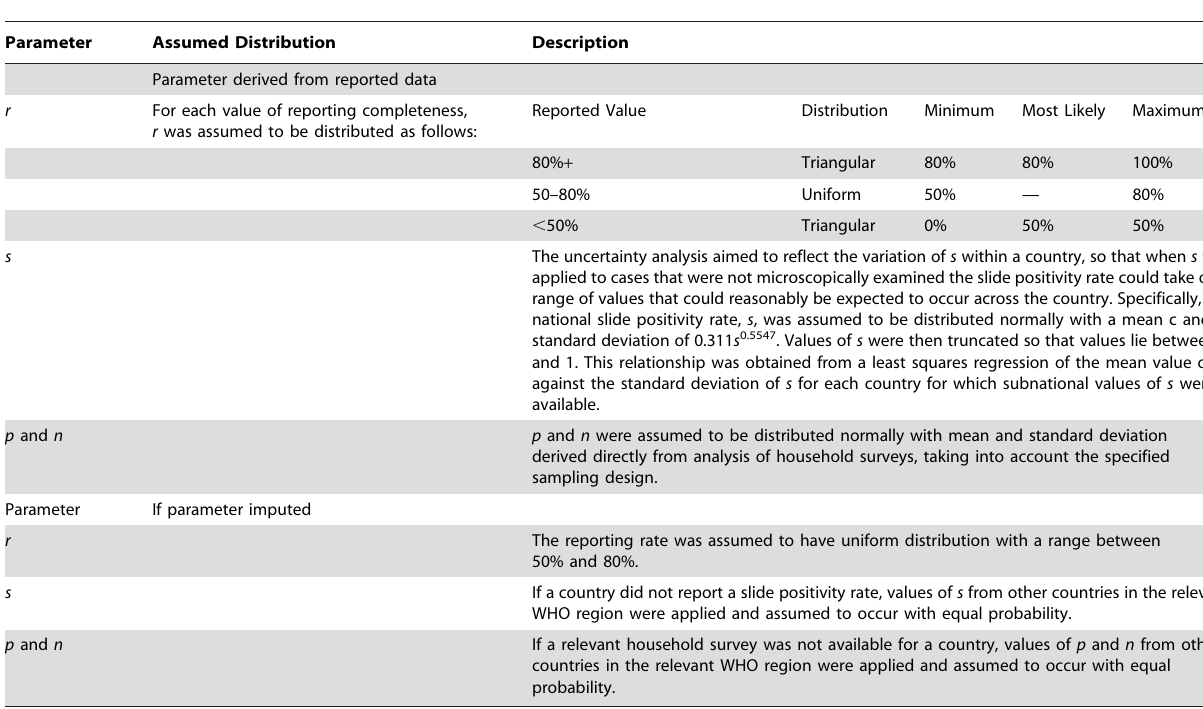
(Table 1). Palisade@Risk (version 5.0) was used to sample from the distributions assumed for each parameter and each country. Latin